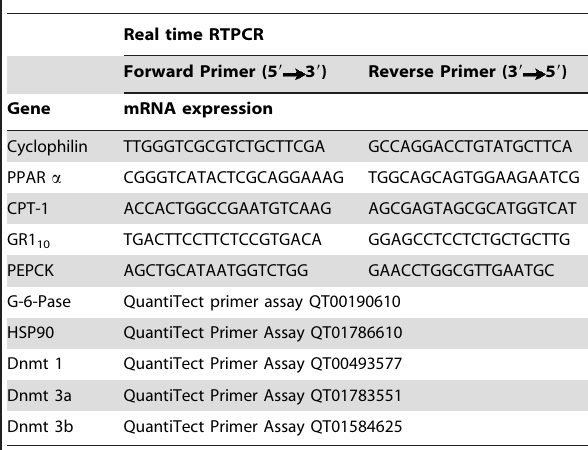
Table 2. Real time RTPCR primers.